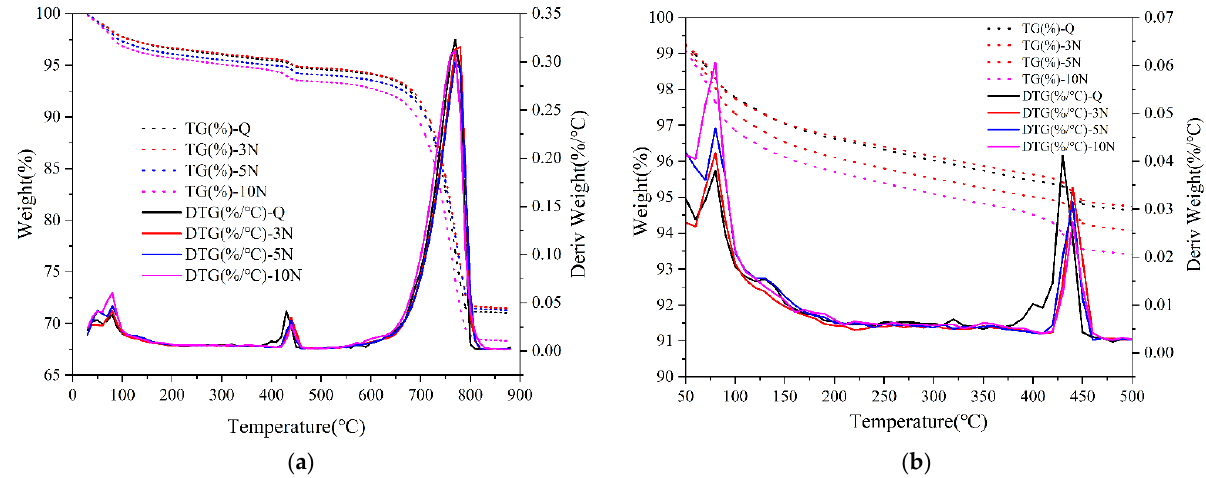
Figure 11. TG/DTG curves of concrete specimens ( a ) different of Na 2 SO 4 contents; ( b ) the first peaks of AFt and Gyp.